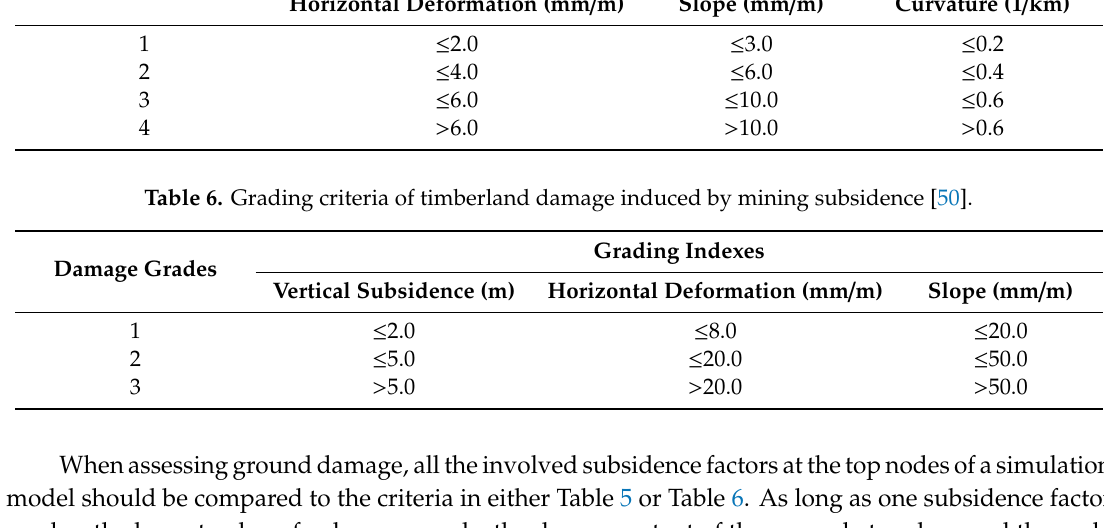
Table 5. Grading criteria of building damage induced by mining subsidence [33]. Damage Grades